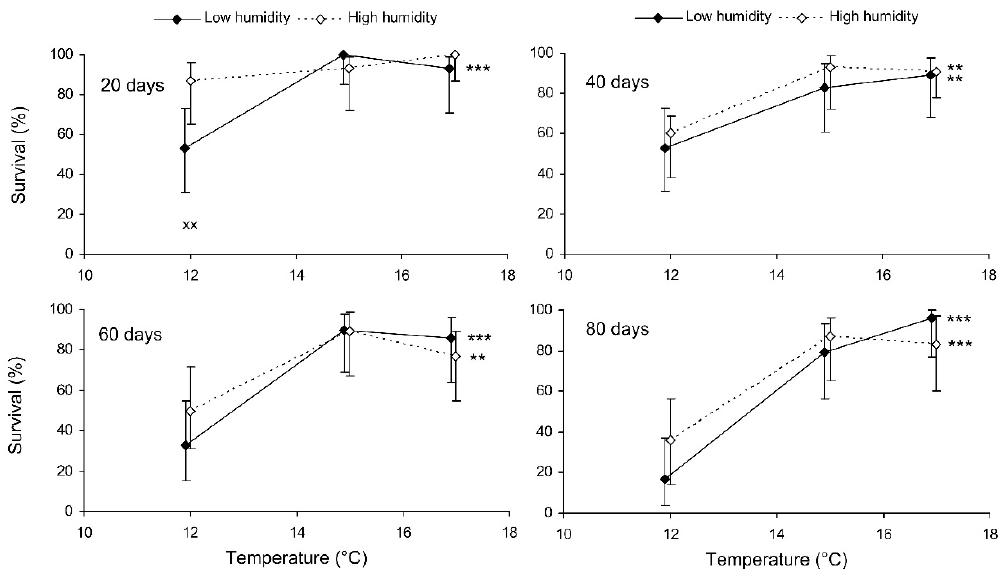
Figure 2. Survival of fed Cheilomenes propinqua females in relation to the temperature, humidity, and duration of storage (the results of the long-term experiment). Percentages with 95% confidence intervals are shown. The duration of storage is indicated in the graphs. Asterisks at the right end of the line indicate a significant influence of temperature—**, p < 0.01, ***, p < 0.001—according to the chi-square test. X-crosses indicate the significant influence of humidity at the corresponding temperature, ××— p < 0.01, according to the Mantel–Haenszel chi-square test (the trophic regime was used as a strata variable).